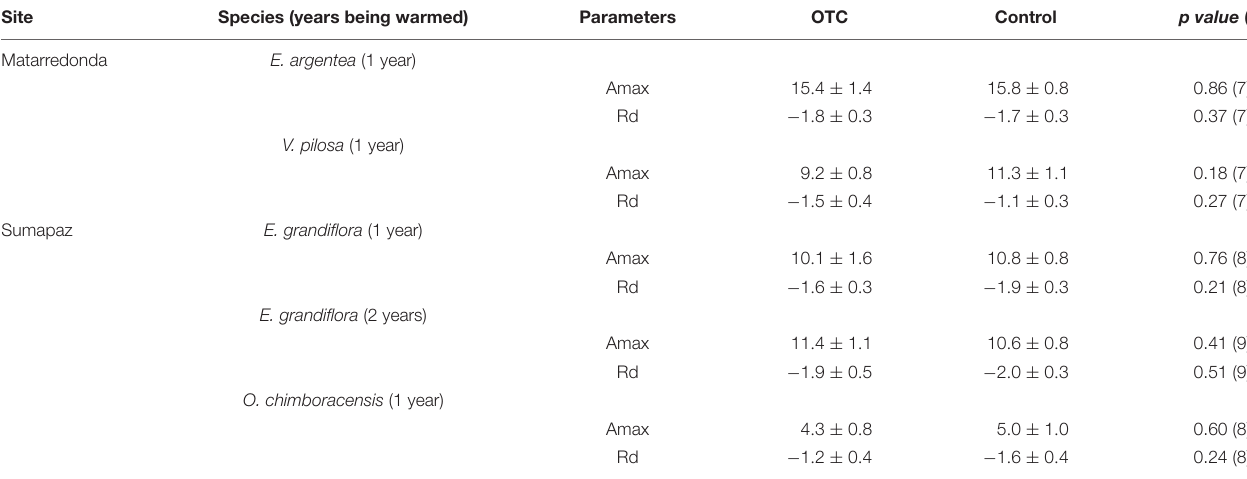
Site Species (years being warmed) Parameters OTC Control p value